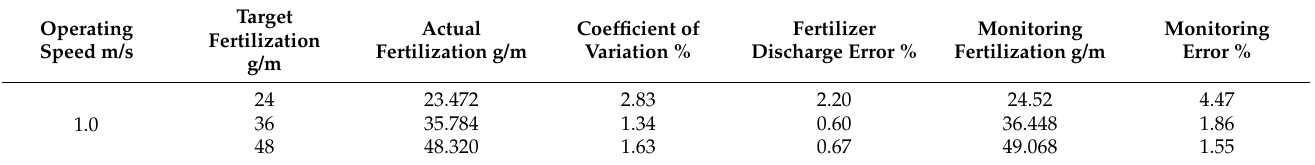
Figure 16. Precision test of fertilizer discharge under different amounts. Table 7. Fertilizer discharge precision test of variable-rate fertilization system under different fertilizer discharge